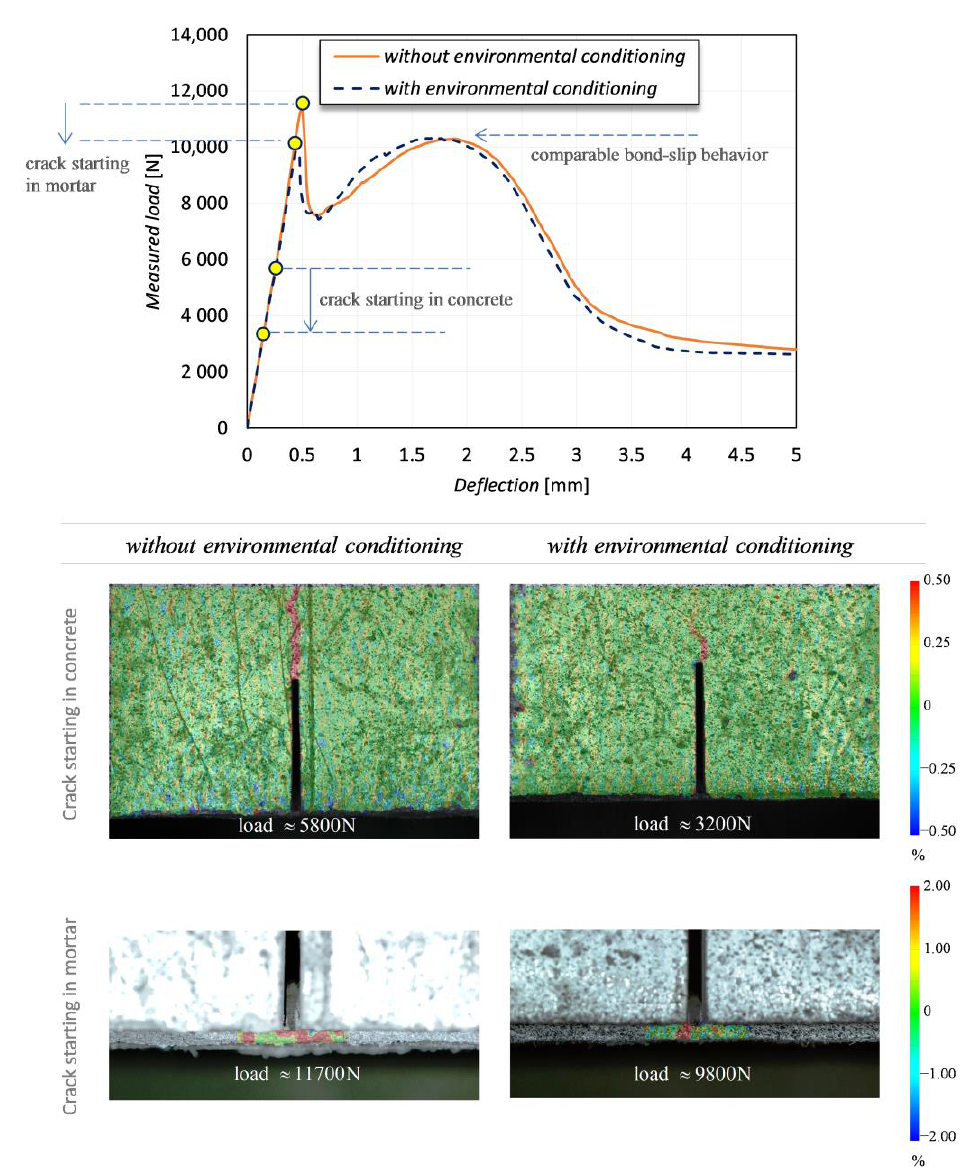
Figure 14. Crack starting in concrete and in FRCM mortar for specimens subject to different curing conditions.